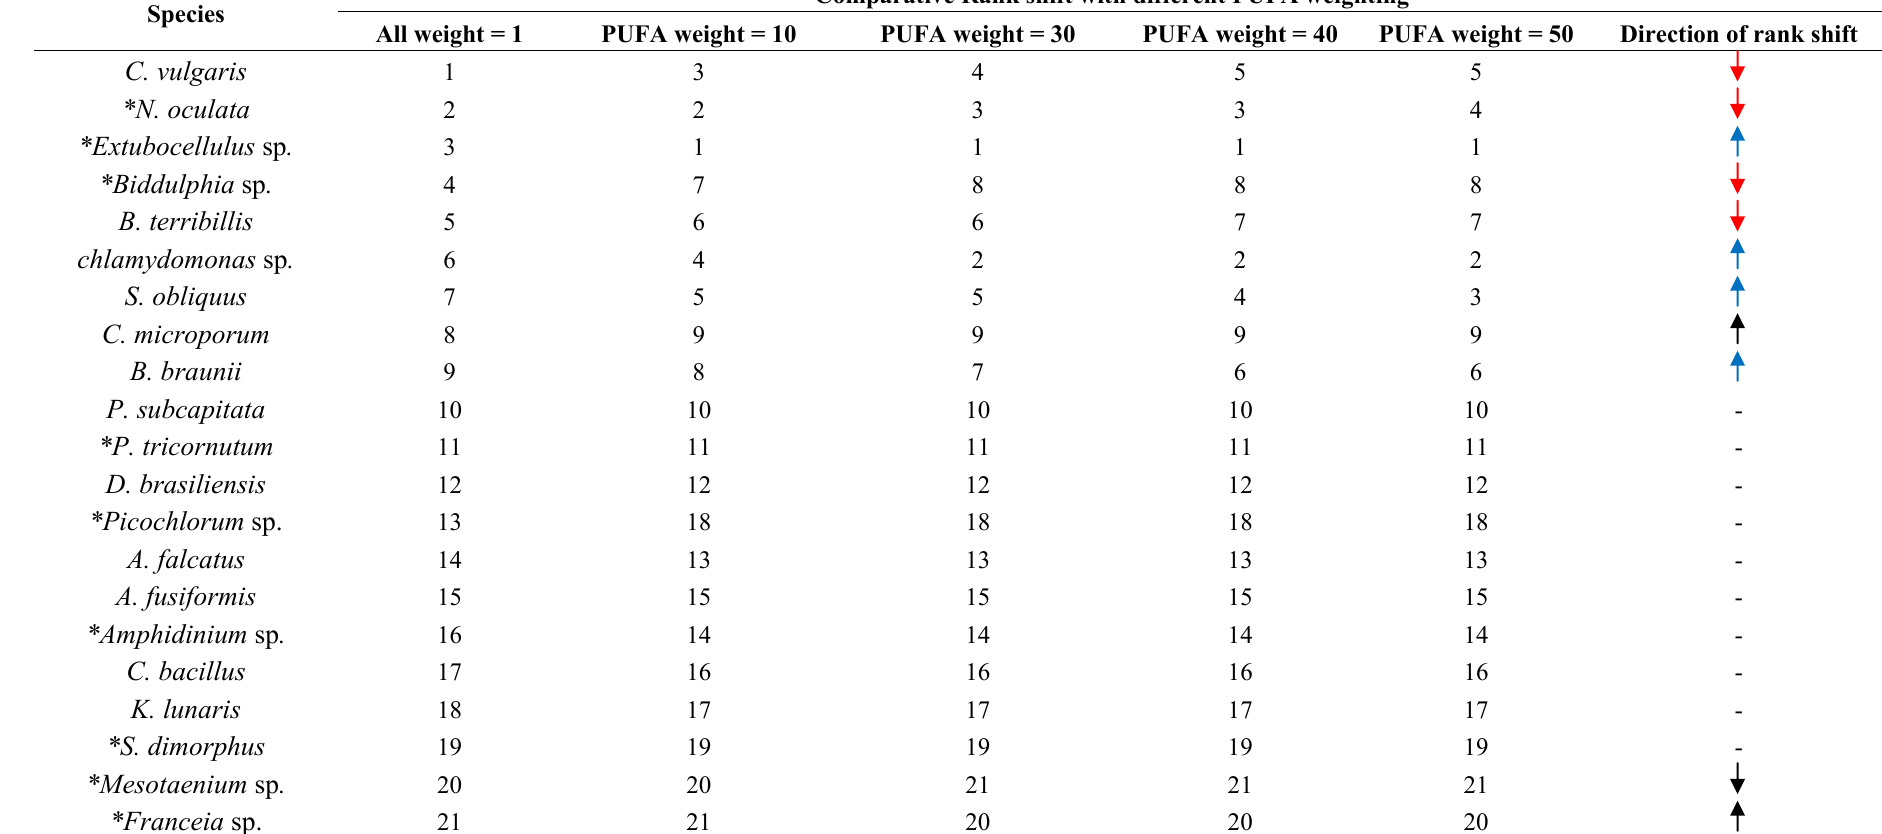
Red arrows: a large decline in ranking for the microalgal species ranked highest under equal weighting of the biodiesel quality parameters; Blue arrows: a large increase in species ranking to top six species rank at a PUFA weighting of 50; black arrows: slight changes in ranking at a PUFA weighting of 50; Hyphen: no ranking change for a PUFA weighting of